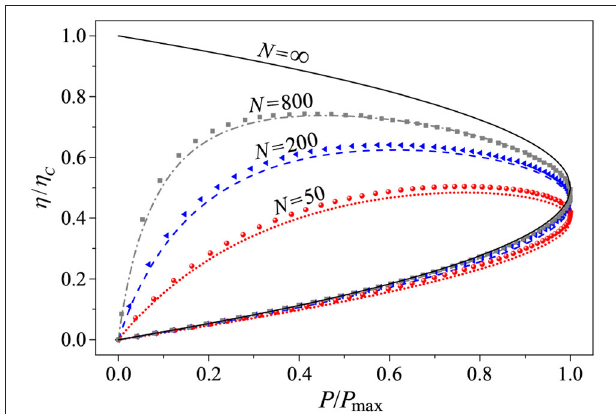
FIGURE 4 | Relative efficiency η/η C vs. normalized power P / P max at different system sizes. The dotted, dashed, and dot-dashed curves represent the linear response predictions at the ZT ( N ) value corresponding to the given system N . The solid line is the linear response curve for ZT size 3 = N ). The model parameter values are as in Figure 3 , with 1 T = ∞ ( T L 1.1 and T R 0.9). Adapted with permission from Luo et al. [ 103]. = = Copyright © 2019 American Physical